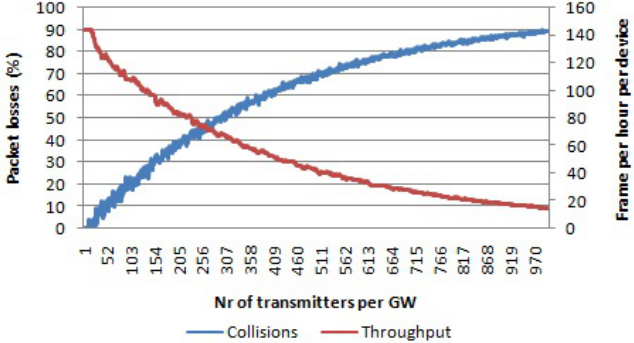
Figure 14. Percentage of packets lost due to collisions per number of transmitters per gateway using pure Aloha access. Average throughput per device. Payload size 20 bytes, multiple channels, multiple